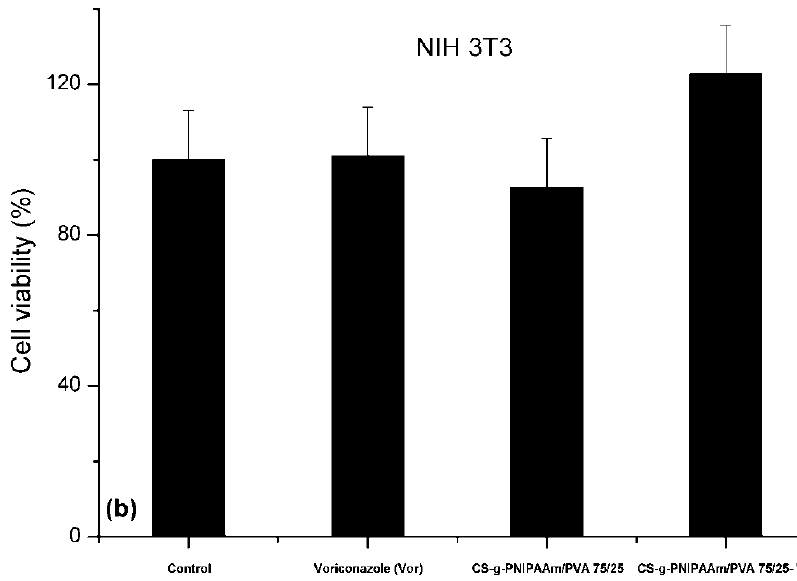
Figure 10. ( a ) Evaluation chart of cytotoxicity potential of the CS- g -PNIPAAm / PVA 75 / 25 based formulations prepared by MTT assay on human kidney tubular epithelial cells (HK-2). ( b ) Evaluation of cytotoxicity potential of CS- g -PNIPAAm / PVA 75 / 25 based formulations prepared by MTT assay on rat embryonic fibroblast cells (3T3). The bars show the value of “average ± standard deviation”. The values over the bars represent % cell viability in comparison to the control samples (* means the cell viability was increased in a statistical manner; p < 0.05; n = 4).